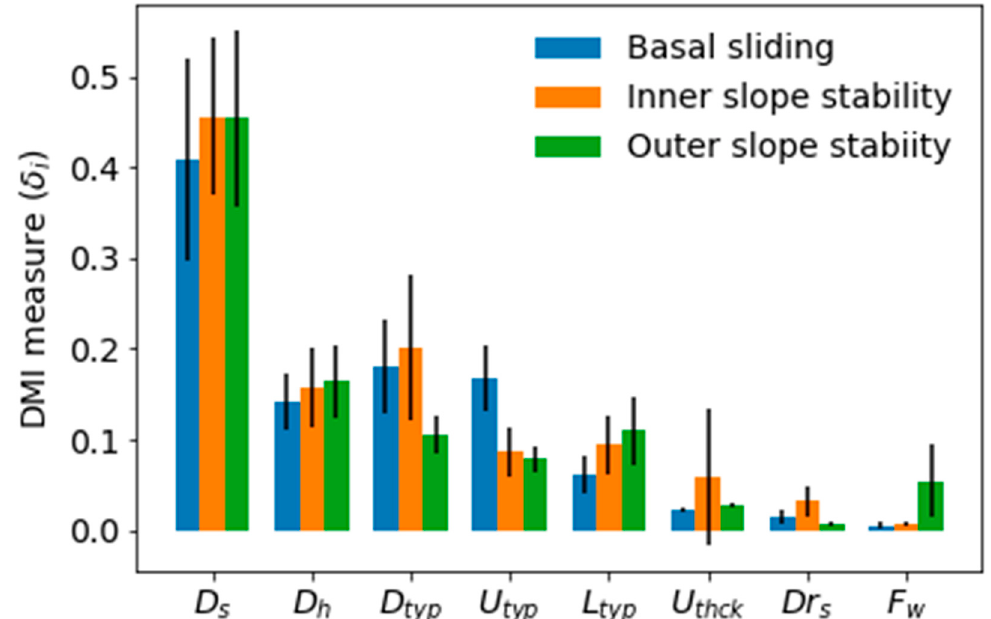
Figure 7. Results of global sensitivity analysis (DMI-method). The bars indicate the Delta Moment-Independent measure ( δ i ) per failure mechanism where higher values indicate a greater sensitivity of the factor of safety to that variable (Table 1). Error bars show the values ± 1 standard deviation (1 σ ). Wider error bounds indicate greater variance in the sensitivity for that parameter, possibly caused by parameter interaction.